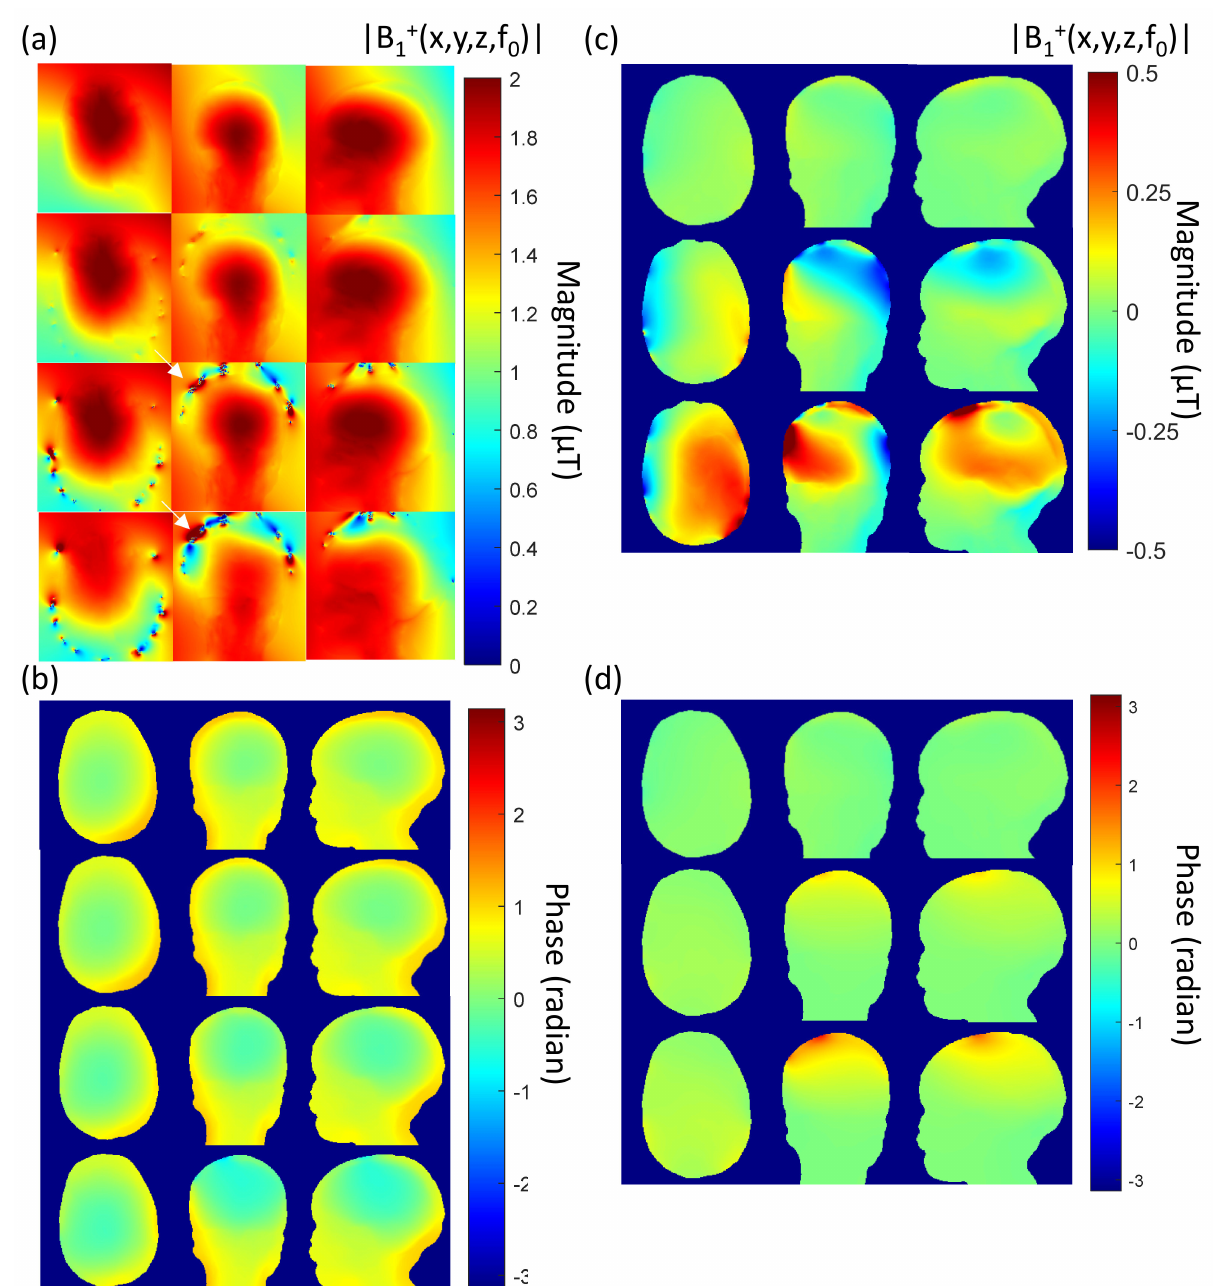
Figure 9. (Left column) ( a ) Simulated B 1 transmit field distribution magnitude and ( b ) phase; axial (left), coronal (middle), and sagittal (right) view in the case of NoNet, NeoNet, and CuNet with ideal current limiting resistors, and CuNet without resistors. Black arrows indicate a decrease (top) and an increase (bottom) in the local B 1 field magnitude. (Right column) ( c ) Difference in the B 1 transmit field distribution magnitude and ( d ) phase; axial (left), coronal (middle), and sagittal (right) view in the case of (top) NoNet–NeoNet, (middle) NoNet–CuNet with ideal current limiting resistors, and (bottom) NoNet–CuNet without